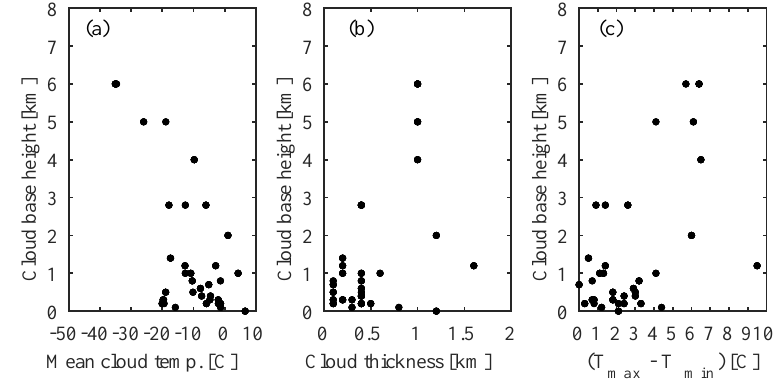
Figure 6. Relationships between the macrophysical properties for the 37 cloud macrophysical scenarios. (a) Cloud base height versus cloud layer mean temperature, (b) cloud base height versus cloud physical thickness, and (c) cloud base height versus cloud layer temperature differential.